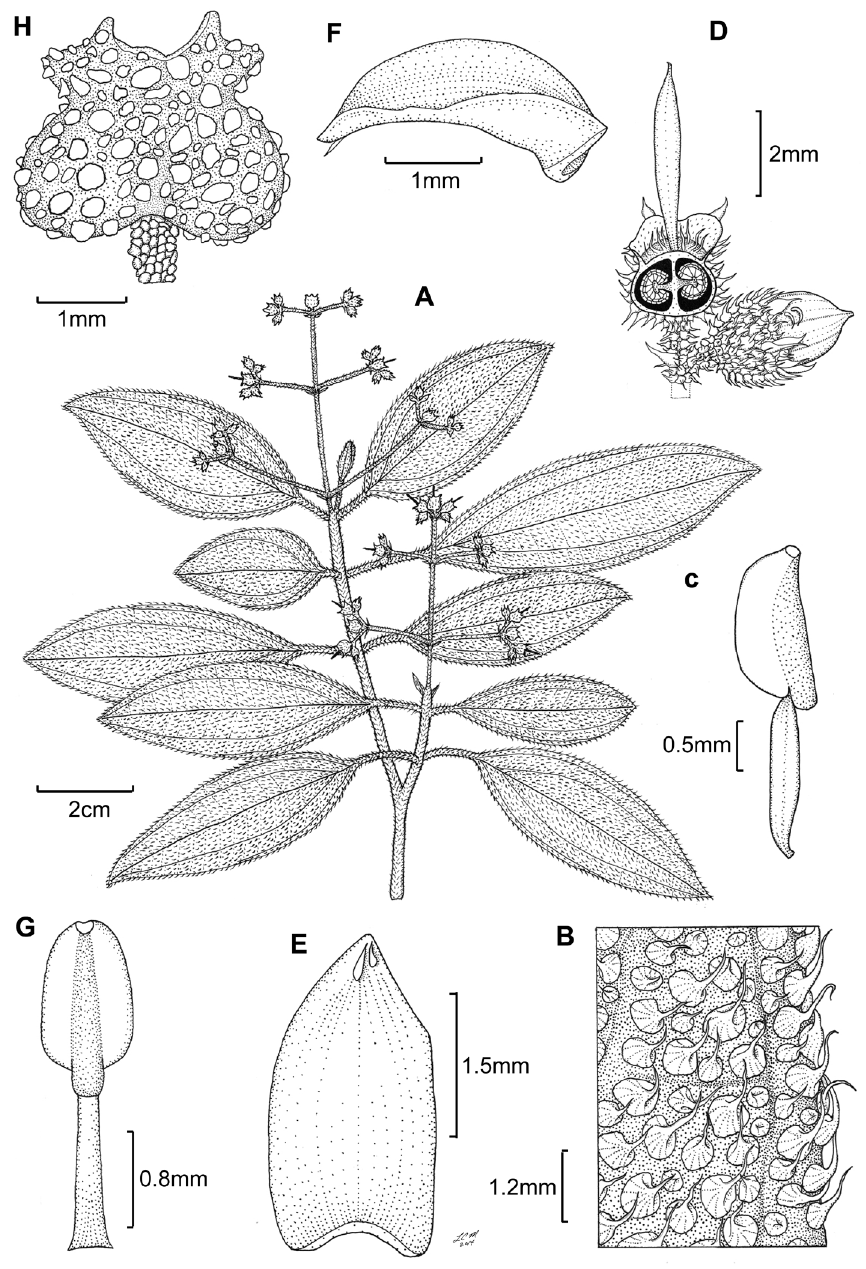
Figure 12. Illustration of Miconia cubana ( A–D ) and M. ottoschmidtii ( E–H ). A Habit of M. cubana B close-up of leaf adaxial surface showing bulla-based hairs not entirely covering areoles C stamen D fruit longitudinal section and flower bud (all from type Wright 189 ) E petal abaxial surface of M. ottoschmidtii showing small, slightly bulla-based hairs F petal side view G stamen showing dorso-basal appendage ( E–G from Ekman 6926 ) H fruit showing granulate bulla-based hairs on the hypanthium ( León LS-10046